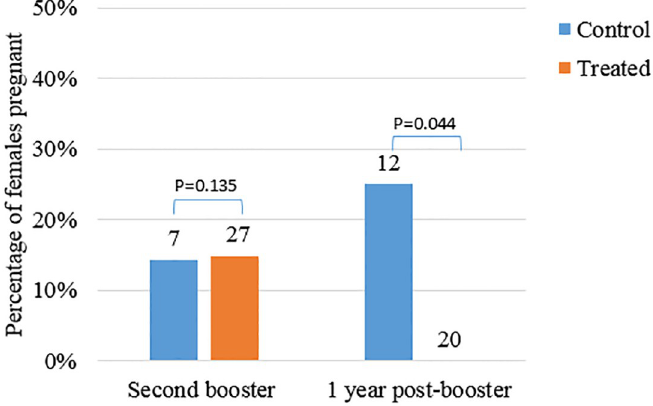
Fig 4. Percentage of pregnant treated and control cattle sampled in 2019 and in 2020. In 2019 cattle were administered a second booster dose of 1 ml of GonaCon, either two or four years after primer vaccination. N = total group sample size.